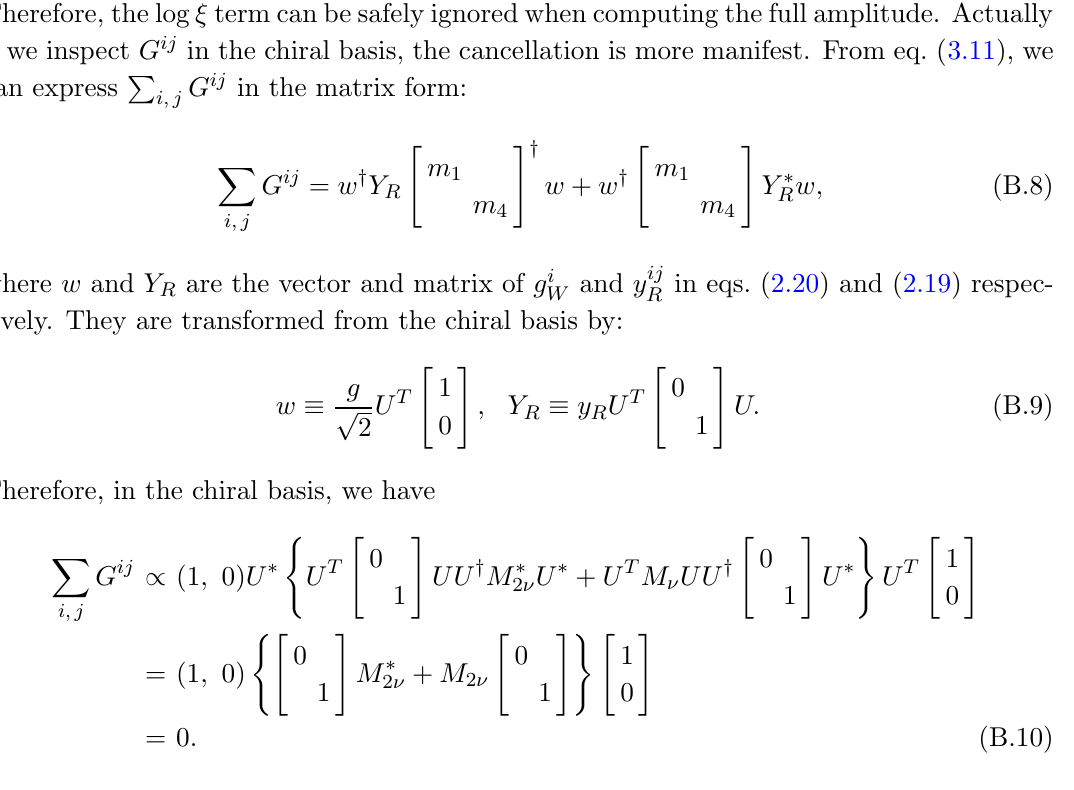
Figure 5 . The Goldstone boson diagram that complements the W dependence in R (cid:24)